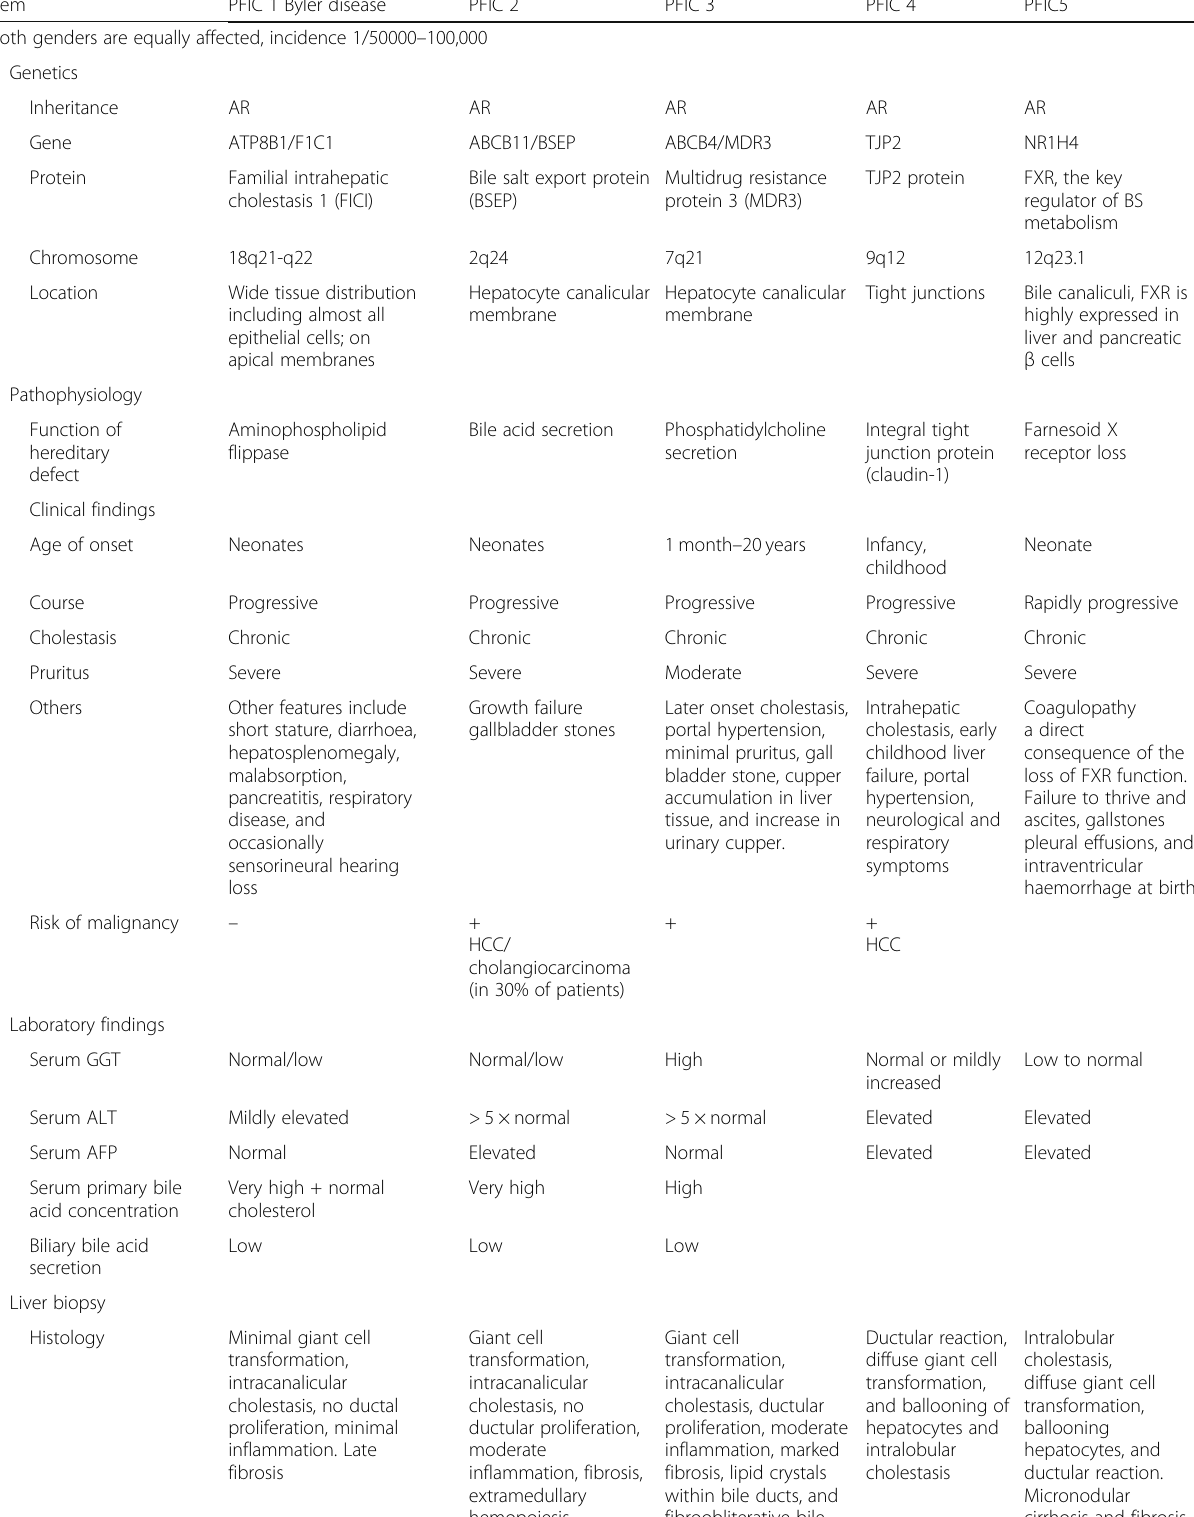
Table 1 Characteristic features of the different types of progressive familial intrahepatic cholestasis [102 – 104]